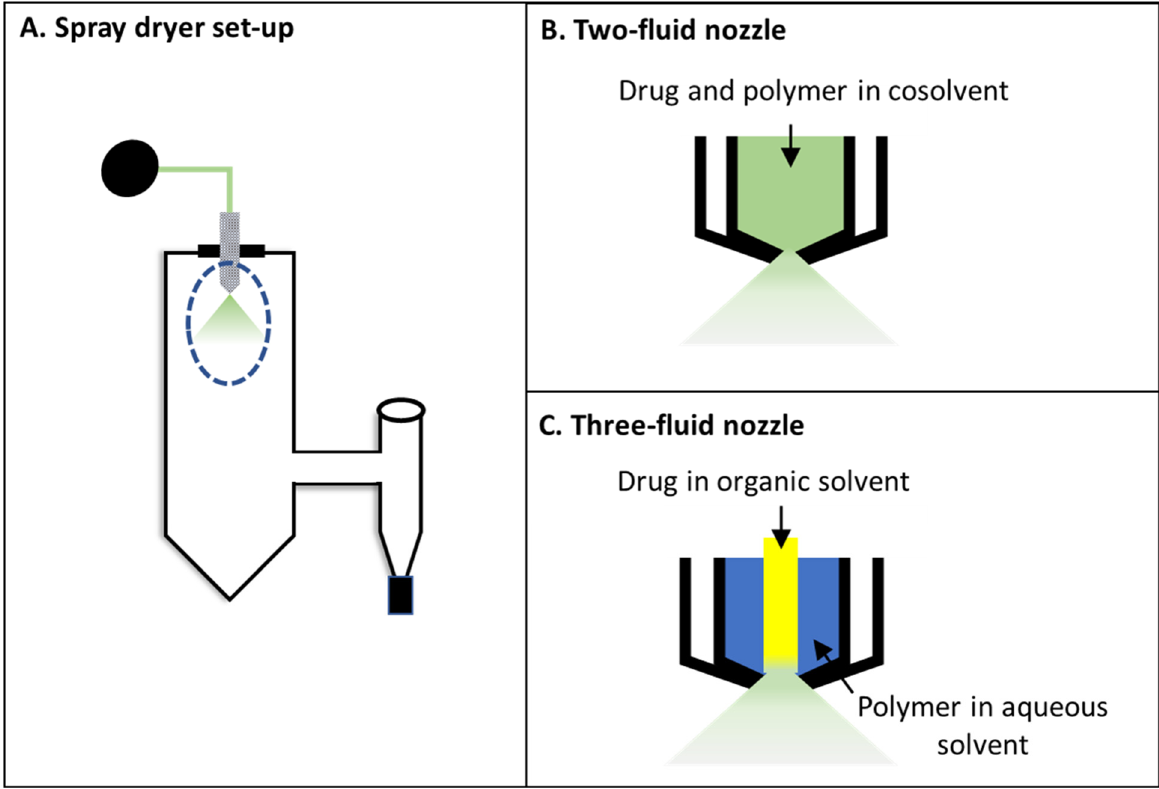
Figure 1. Schematic of a typical ( A ) spray dryer setting; ( B ) two-fluid nozzle; ( C ) three-fluid nozzle (with internal mixing).